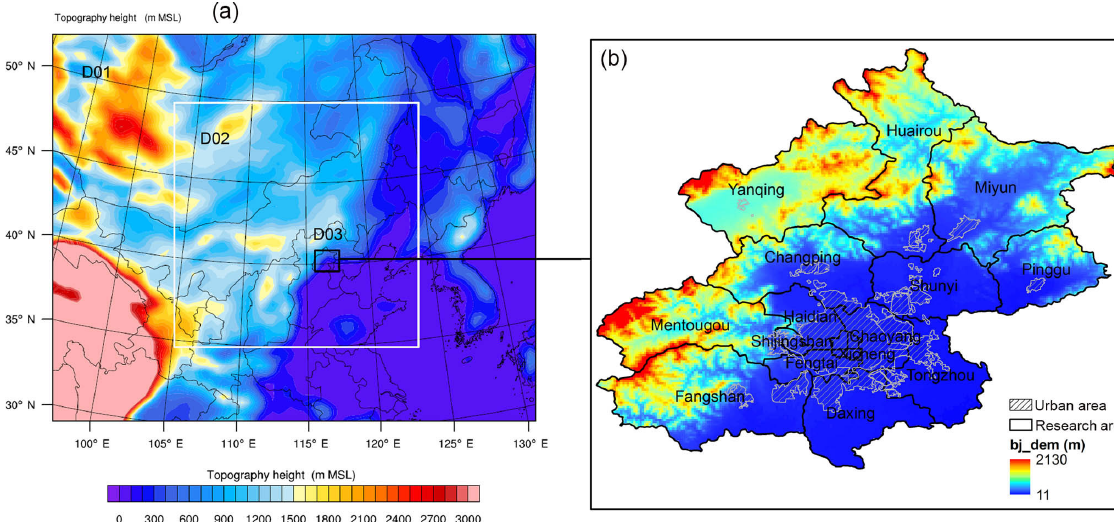
Figure 1. Relative location of the study area. (a) Shows the three nested domains adopted in most of the experiments, of which domain three (D03) covers the entire Beijing area; (b) depicts the geographic features of the Beijing